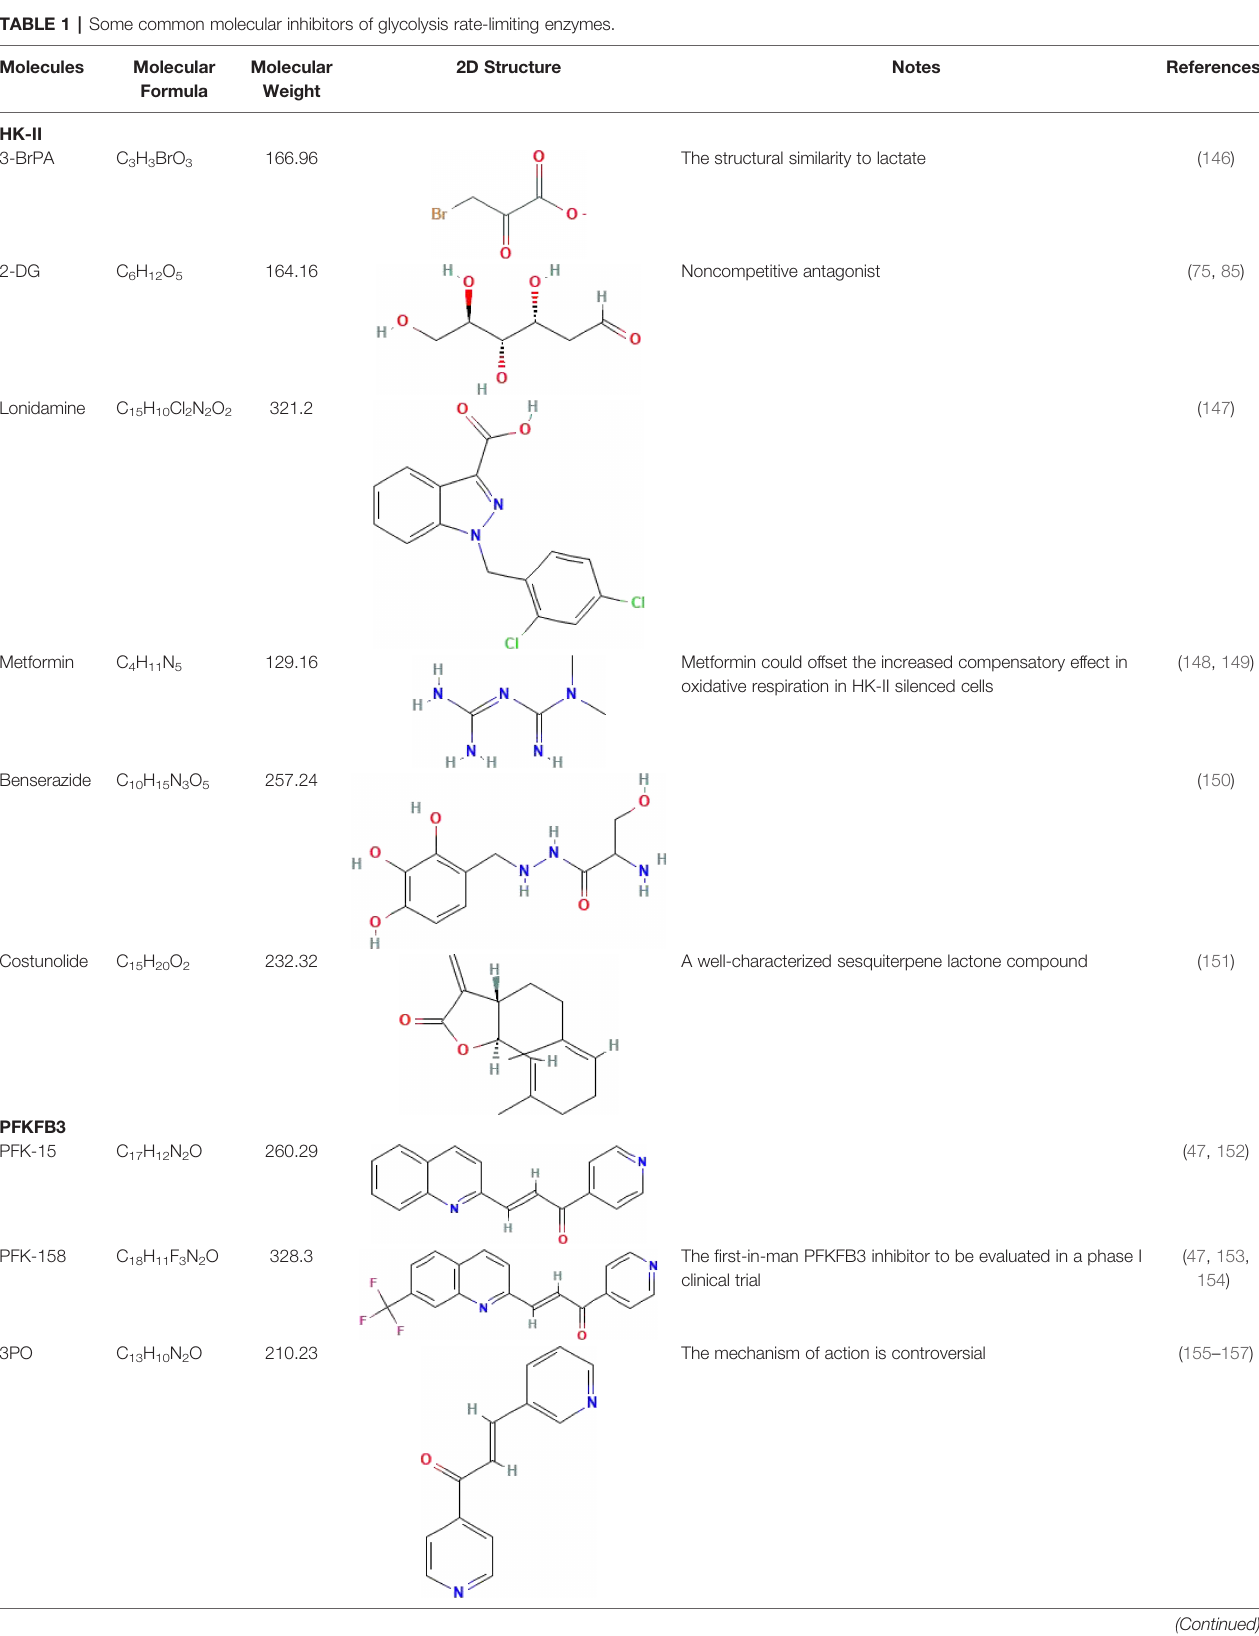
TABLE 1 | Some common molecular inhibitors of glycolysis rate-limiting enzymes.